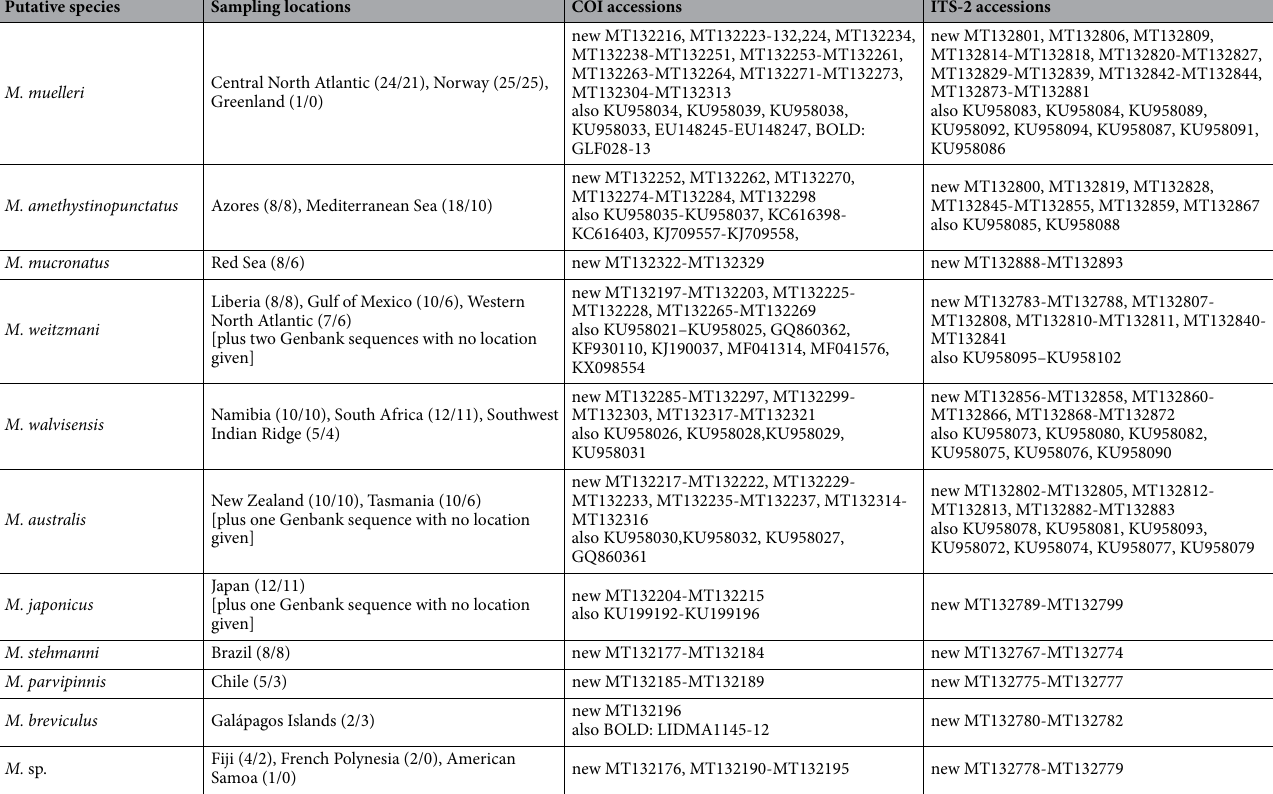
Table 1. Sampling locations for putative Maurolicus species, with an overview of GenBank and BOLD accession numbers for COI and ITS-2 sequences used in analyses. Numbers of sequences per sampling location are given in parentheses for COI and ITS-2, respectively. Further details for new material, including latitude and longitude, are included as part of GenBank